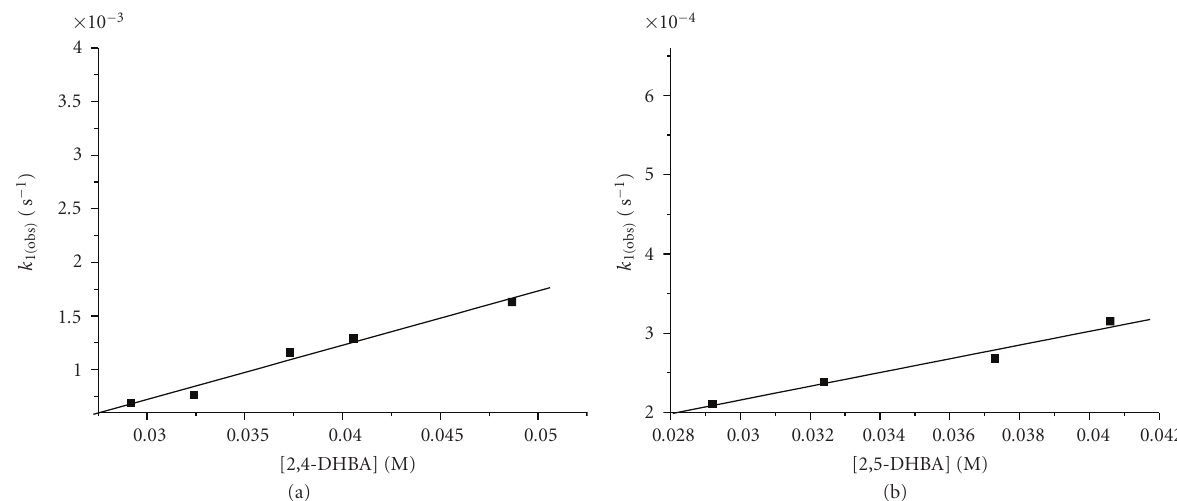
Figure 6: Ligand concentration dependence of k 1(obs) . Conditions: (a) [2,4-DHBA] = 2, 92–4, 87 10 − 2 M, [Cr(III)] = 2, 50 10 − 3 M, T = 296 K, (b) [2,5-DHBA] = 2,92–4,06 · 10 − 2 M, [Cr(III)] = 2,50 · 10 − 3 M, T = 279 K.